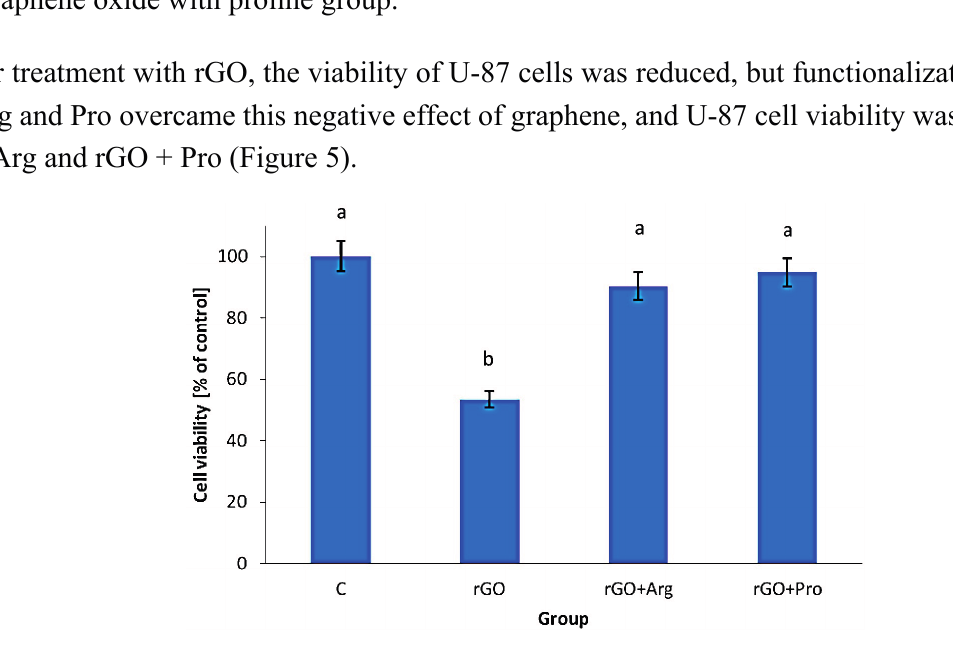
Figure 4. Effect of reduced graphene oxide, reduced graphene oxide with arginine, and reduced graphene oxide with proline on the mortality of glioblastoma U87 cells. Notes: Bars with different superscripts indicate significant differences between groups ( p < 0.05); error bars are standard deviations. C: control group (untreated cells); rGO: reduced graphene oxide group; rGO + Arg: reduced graphene oxide with arginine group; and rGO + Pro: reduced graphene oxide with proline group.